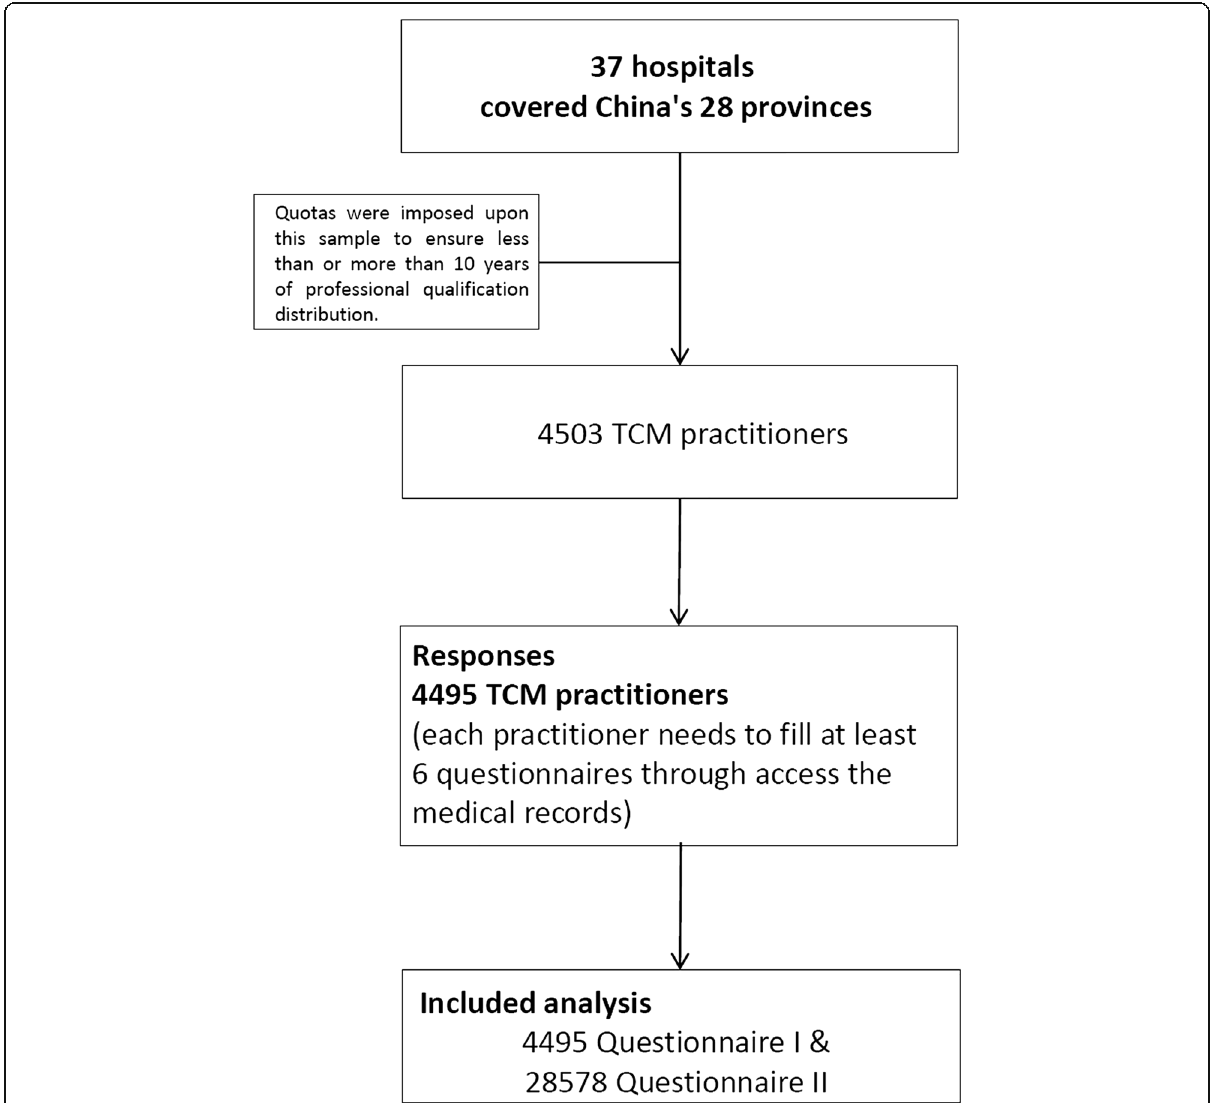
Fig. 1 Flow chart for the survey in traditional Chinese medicine